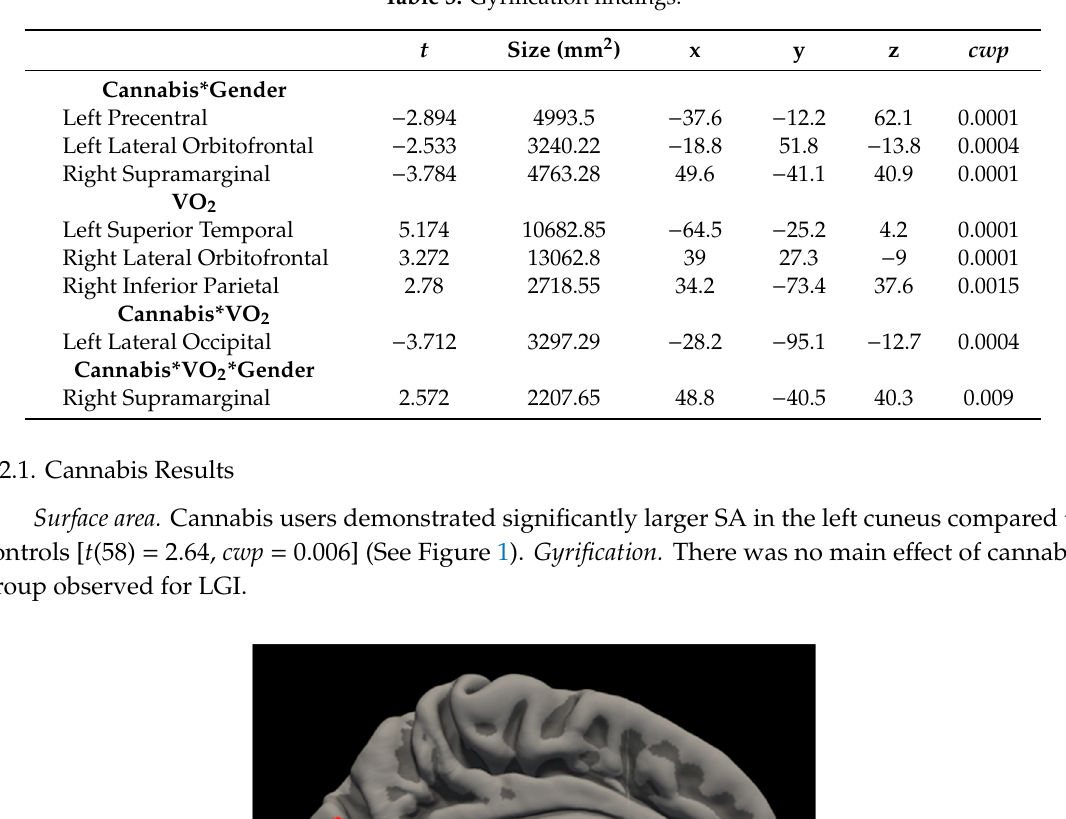
Table 3. Gyrification findings.